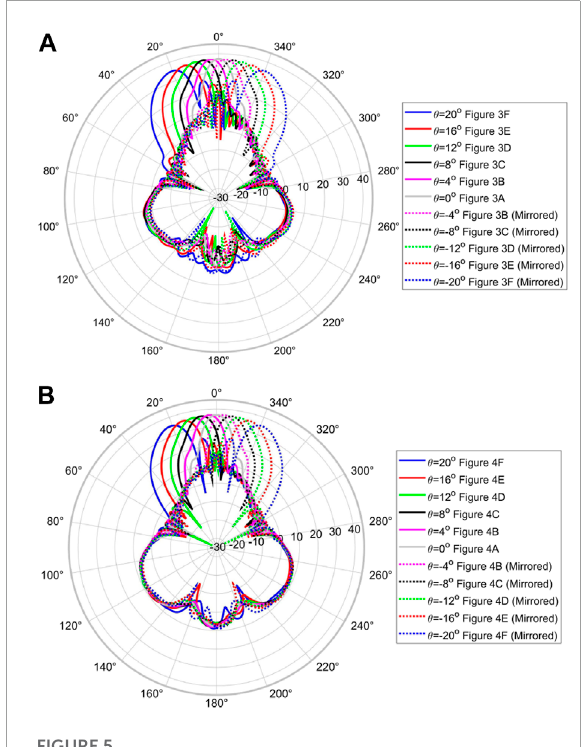
FIGURE 5 Farfield pattern of the EHMFEL in decibels versus θ for (A) the TE 1 mode (corresponding to the results depicted in Figure 3 ) and (B) the TM 0 mode (corresponding to the results depicted in Figure 4 ). The dotted lines represent the cases where the feed location is mirrored with respect to the x -axis.